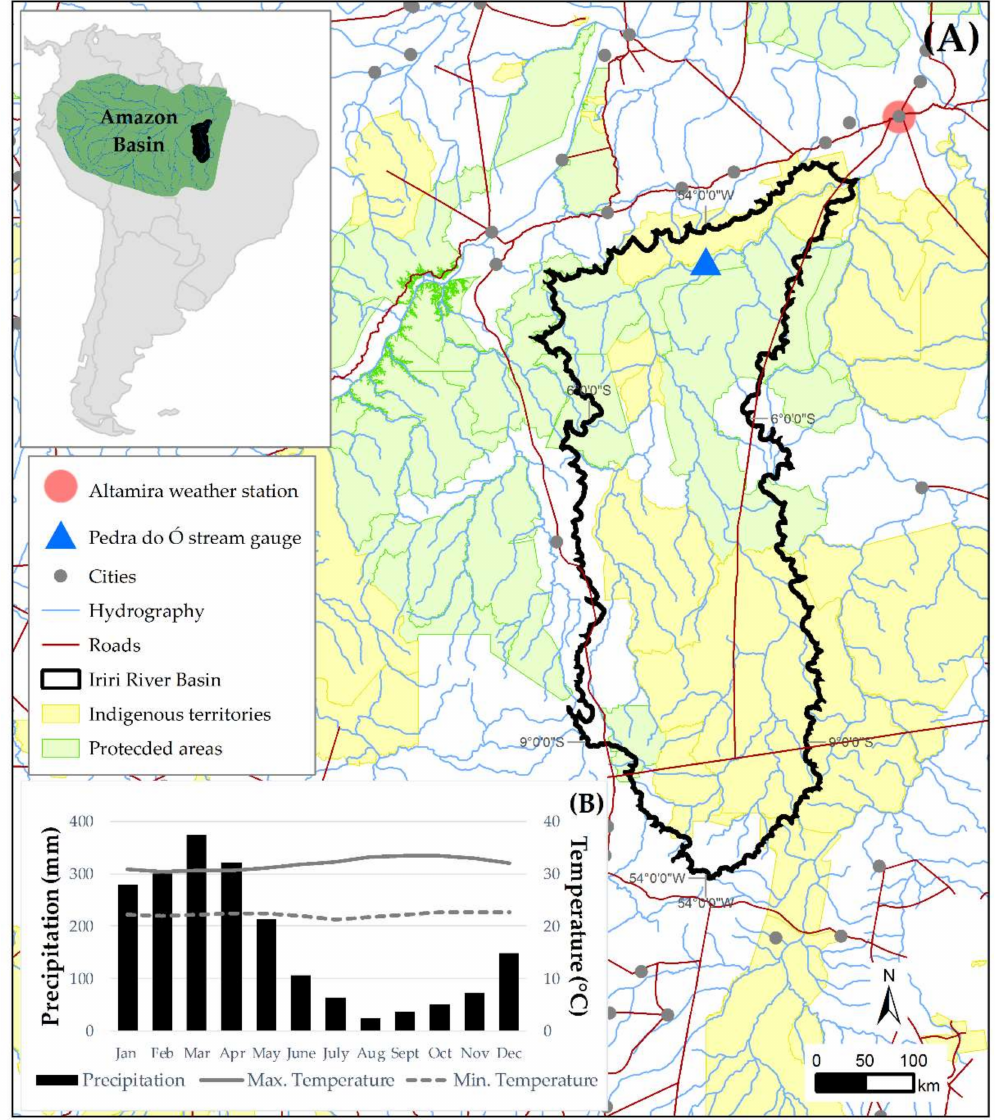
Figure 1. Study area. ( A ) Iriri River Basin and location of indigenous territories and protected areas; ( B ) Precipitation and temperature regimes on Altamira weather